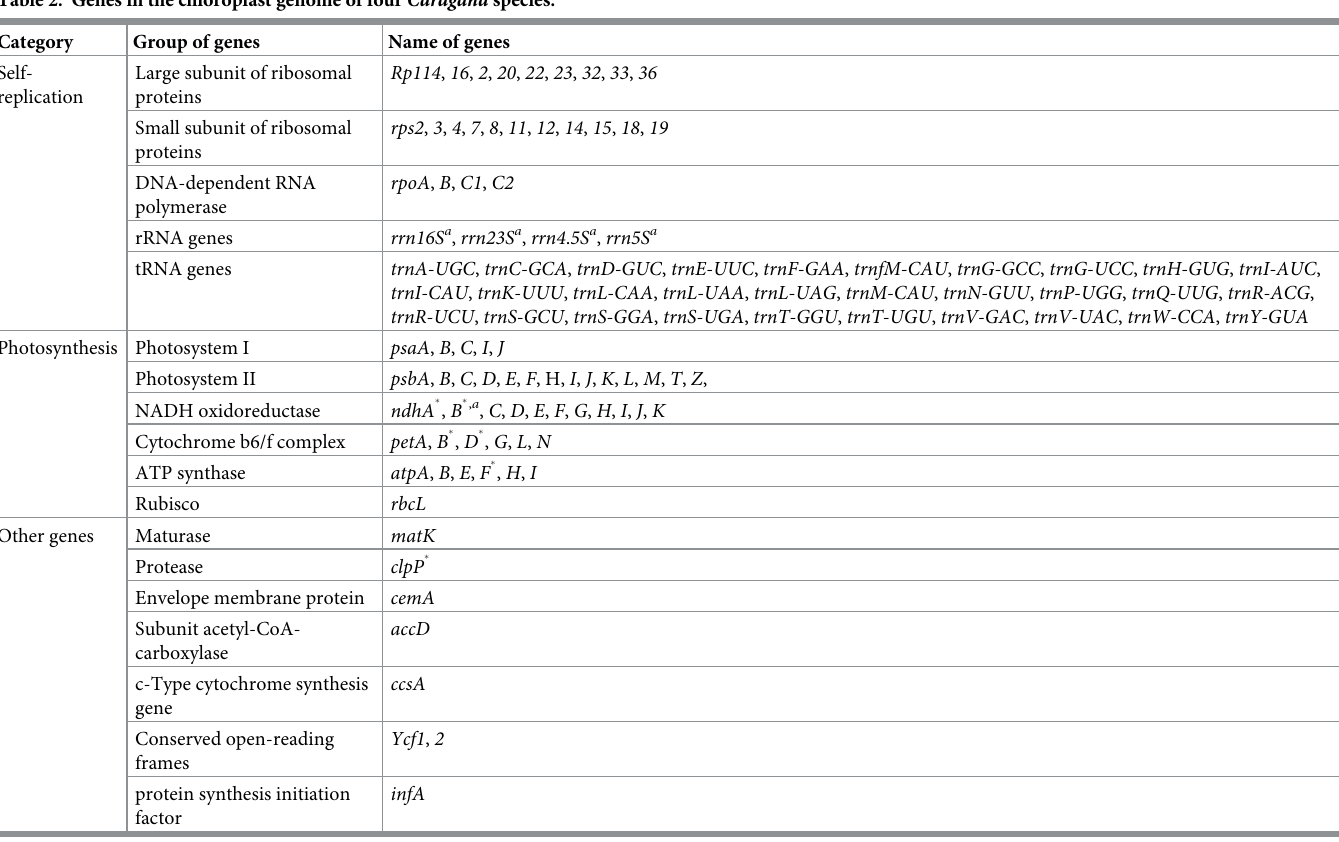
Table 2. Genes in the chloroplast genome of four Caragana species.